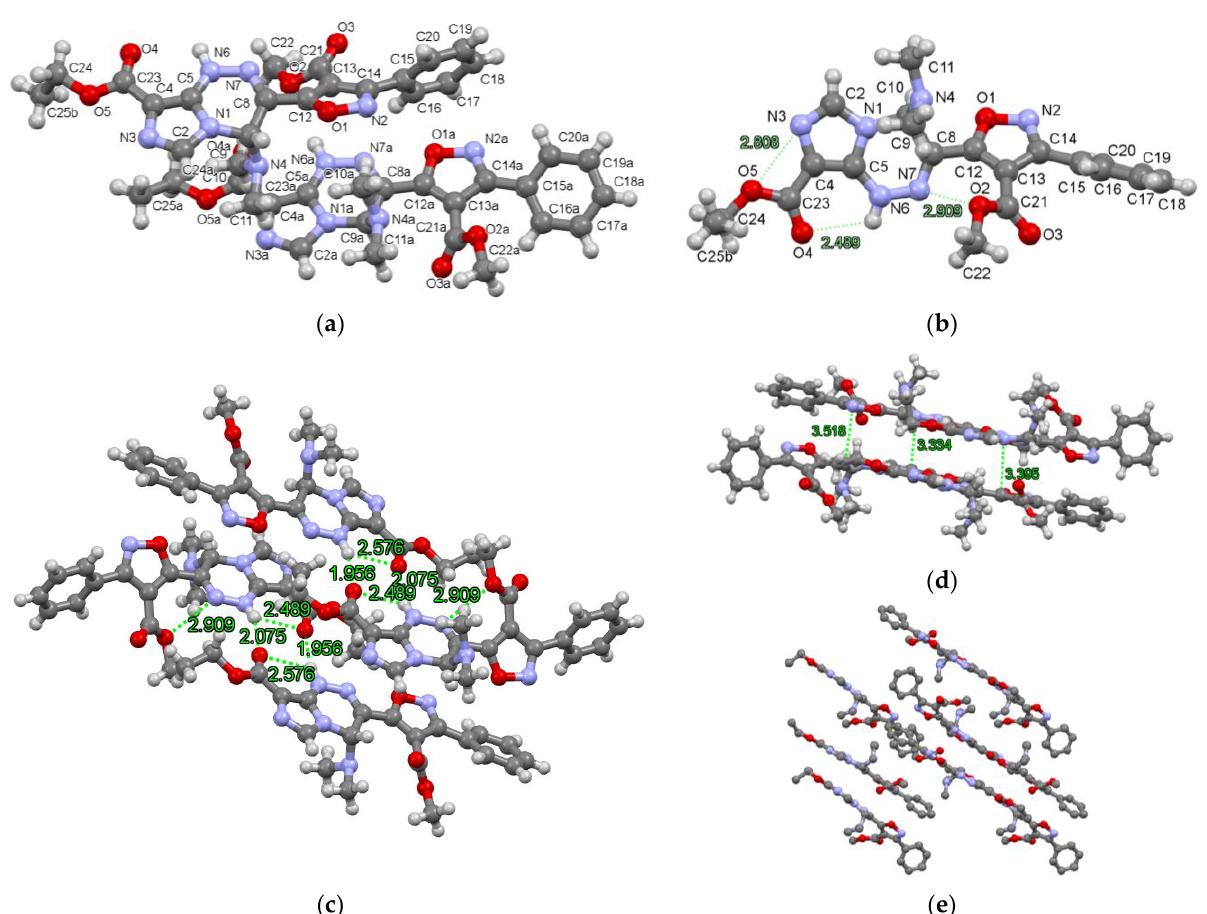
Figure 1. The molecular structure of DAT–NMe 2 11b according to X-ray diffraction data: ( a ) unit of DAT–NMe 2 11b including two molecules; ( b ) front view with intramolecular hydrogen bonding (dotted lines) (RN4H–O3 = 2.302 Å; RN5H–O1 = 2.968 Å); ( c ) location of neighbored molecules and intermolecular noncovalent bonds (R VdW (O–H) = 2.5 Å, R VdW (N–H) = 2.6 Å, R VdW (N–O) = 3.35 Å, R VdW (N–O) = 3.25 Å); ( d ) arrangement of molecules in two parallel sheets; ( e ) partial packing diagram along the crystallographic axis a. Hydrogen atoms omitted for clarity.